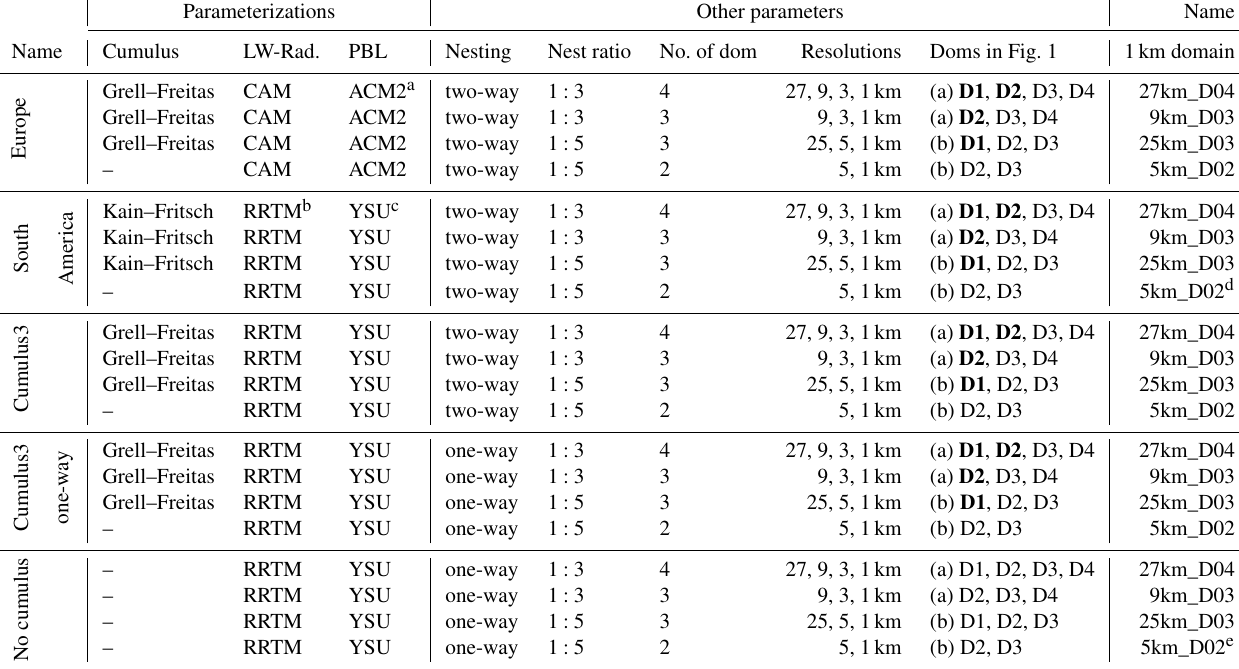
Table 1. Experimental design of the sensitivity simulations: name of the experiment, parameterizations used, and other parameters important for each experiment, such as nesting option and ratio, number of domains, the spatial resolution of the used domains, and their corresponding names as they appear in Fig. 1. Domains written in bold indicate that the according cumulus parameterization is turned on, while domains printed in normal fonts do not parameterize cumulus processes. The last column provides the name of the innermost domain, which is used in figures to identify nesting and resolution options. All other options used for the simulation can be found in the namelist files on Zenodo (see code and data availability